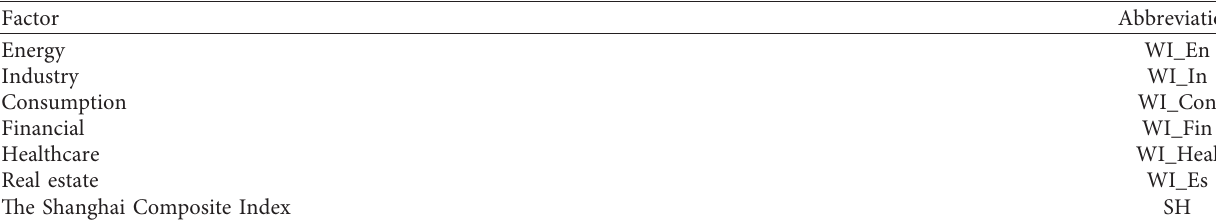
Table 3: Stock market factors